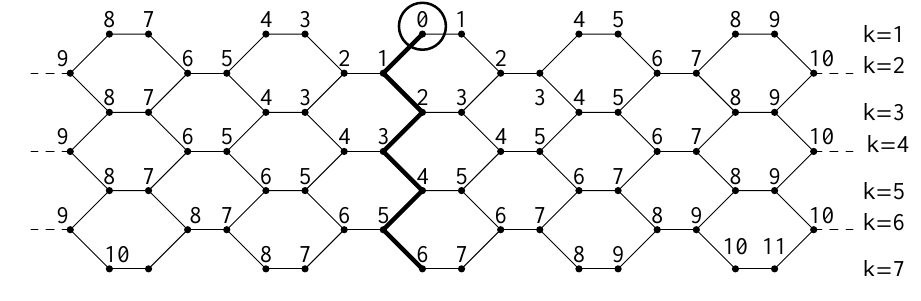
[2 p, q ] with p = 5 and q = 7 6